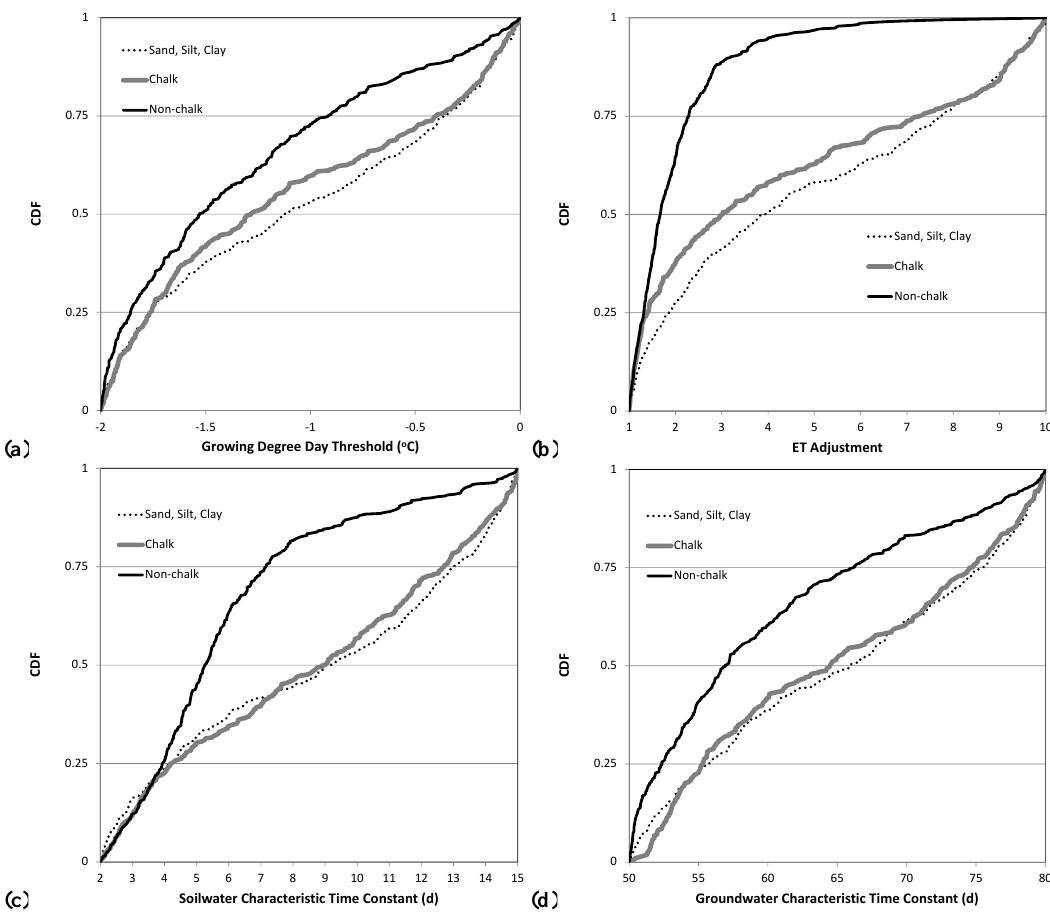
Fig. 8. (a) Cumulative distribution plot of growing degree thresholds for the three hydrologic response types. The KS statistics for the chalk and Quaternary (sand, silt, clay) hydrologic response types are not statistically significant, suggesting model performance is only sensitive to values in the non-chalk hydrologic response type. (b) Cumulative distribution plot of evapotranspiration adjustment factors for the three hydrologic response types. (c) Cumulative distribution plot of soil water characteristic time constants for the three hydrologic response types. (d) Cumulative distribution plot for groundwater time constants for the three hydrologic response